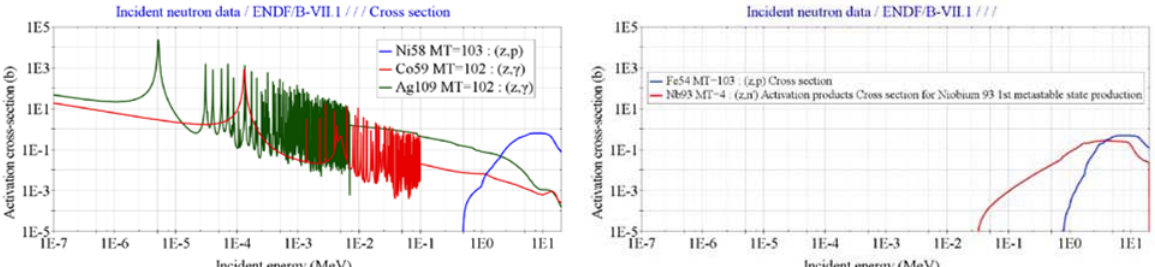
Figure 6. Dosimeters employed in Ref [1] for validation of the PWR BS activation simulations (left) and in Ref [9,14] for validation of the PWR RPV FNF simulations